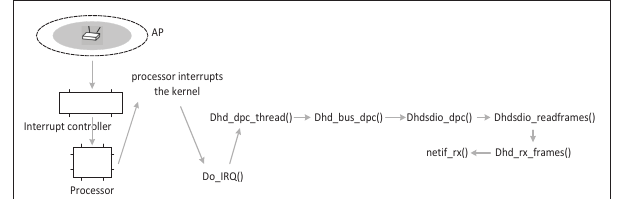
Figure 6. Trace of API for Resume